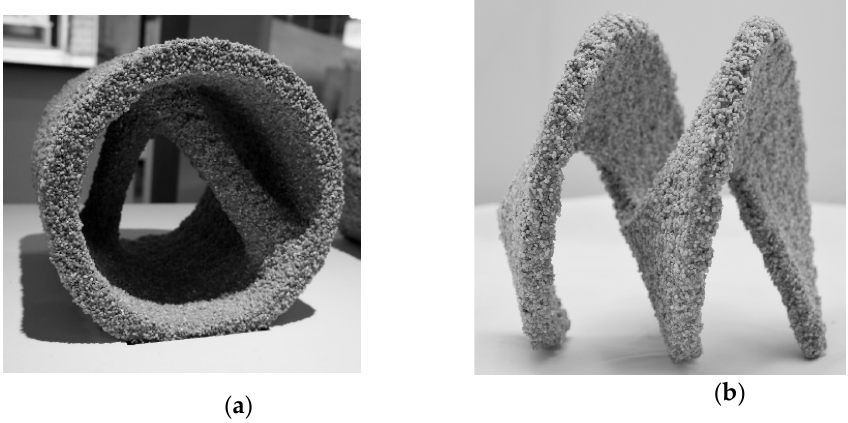
Figure 4. ( a ) SPI manufactured tube with internal double bracing; ( b ) SPI manufactured Helix (wing thickness 0.015 m), credit of picture ( b ): C. Matthaeus.